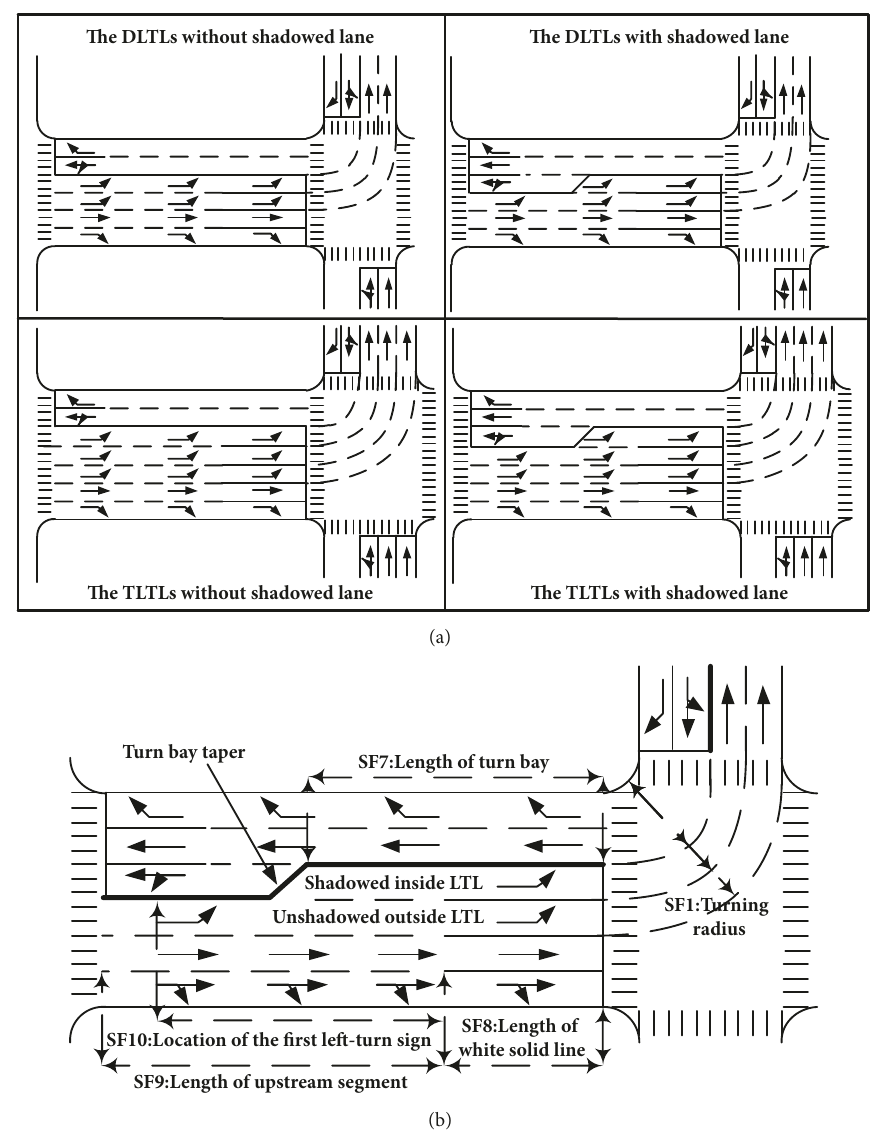
Figure 1: (a) Typical configurations of the DLTLs and the TLTLs. (b) An example configuration of the DLTLs.